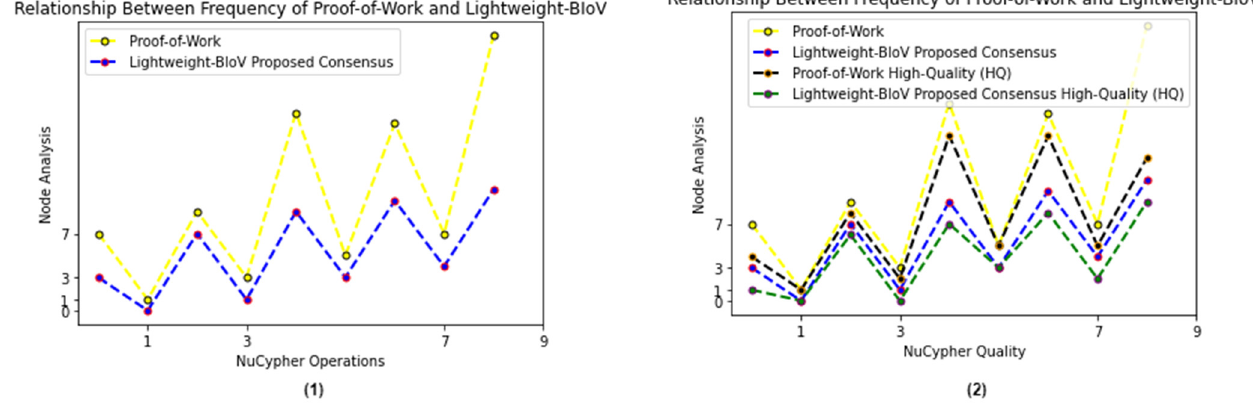
Figure 5. The Computational Cost Utilization: ( 1 ) Demonstrates the Relationship between the Proof- of-Work and BIoV Consensus Using NuCypher Operations and Node Capability. ( 2 ) Demonstrates the Large Scale of High-Quality Measurement.